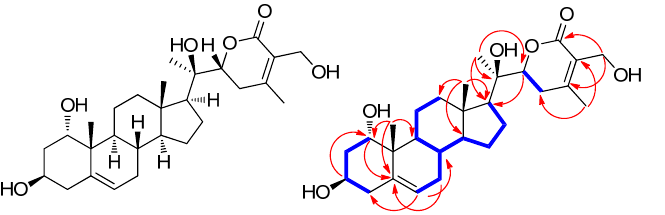
Figure 6. Structure of 1a and key 1 H- 1 H COSY ( ) and HMBC ( ) correlations for 1a .